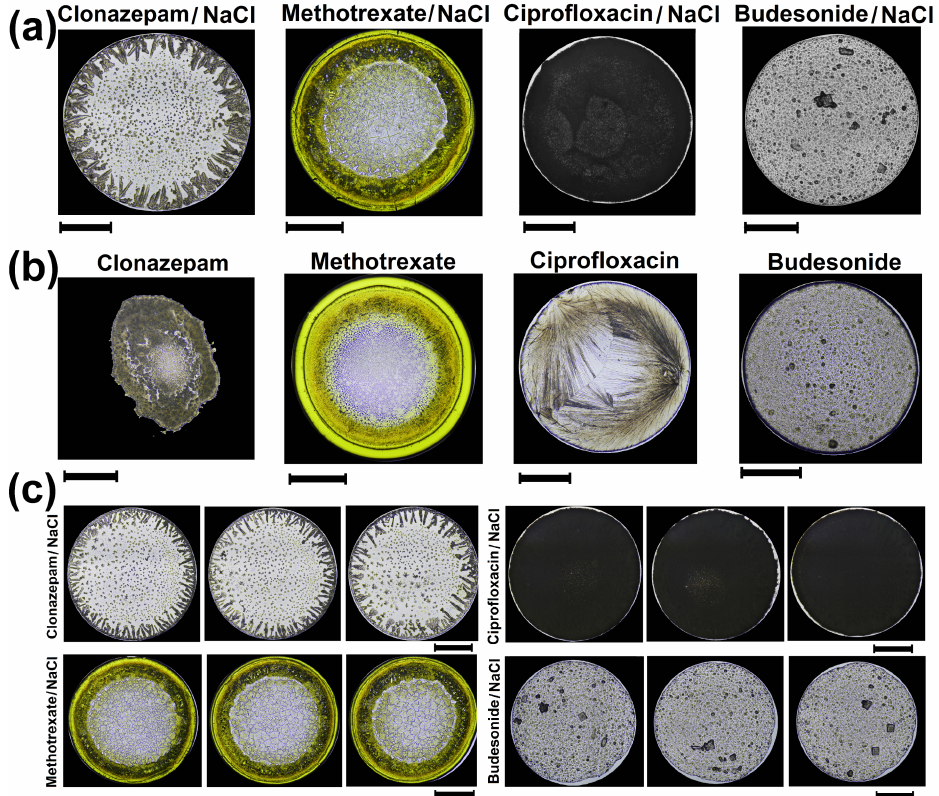
Figure 1. Patterns in dried droplets of medicines ( a ) Patterns of dried droplets of Clonazepam, Methotrexate, Ciprofloxacin and Budesonide with NaCl formed at 63 ◦ C (RH = 25%). ( b ) Patterns of dried droplets of Clonazepam, Methotrexate, Ciprofloxacin, and Budesonide without NaCl formed at 63 ◦ C (RH = 25%). ( c ) The high reproducibility in the pattern formation of Clonazepam, Methotrexate, Ciprofloxacin and Budesonide with NaCl. The length of the black lines indicate 1